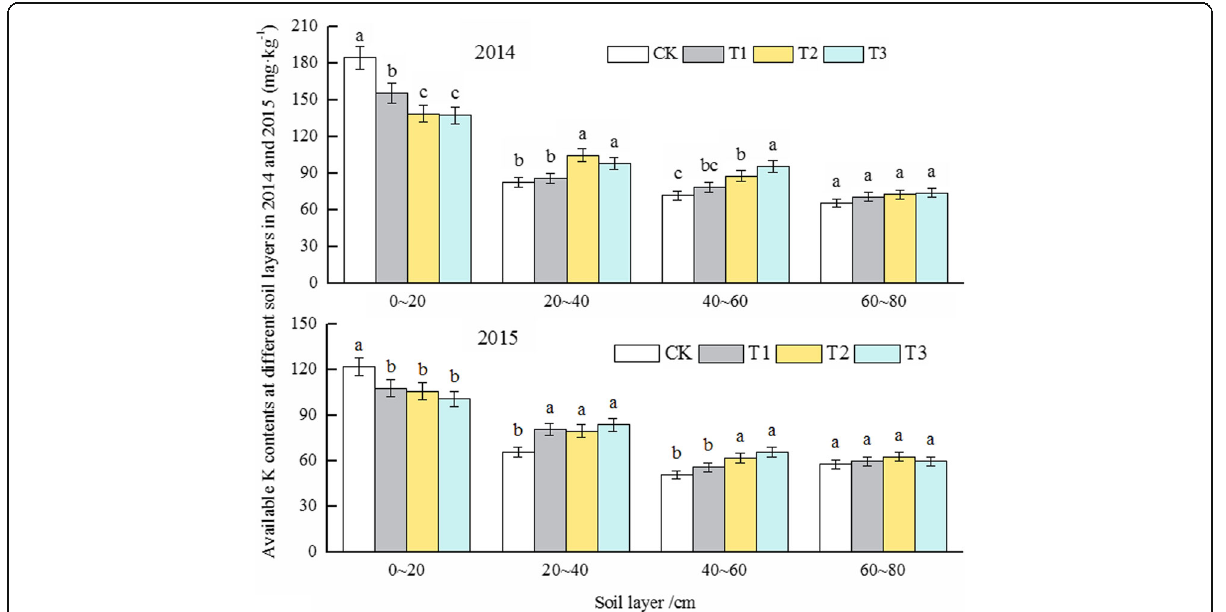
Fig. 7 Changes in available soil K contents in different soil layers in different treatments in 2014 and